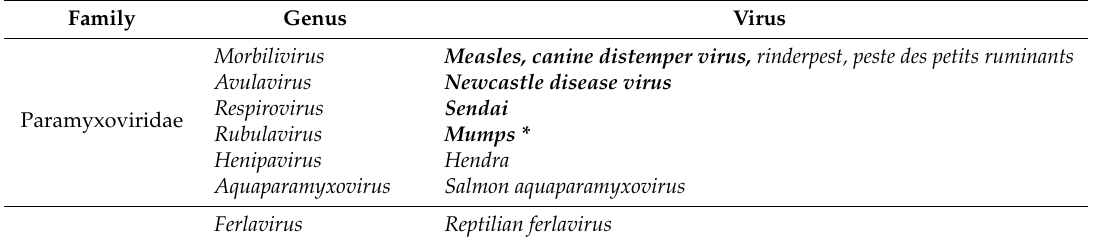
Table 1. Paramyxoviridae family and genera. Oncolytic paramyxoviruses are marked in bold. Family